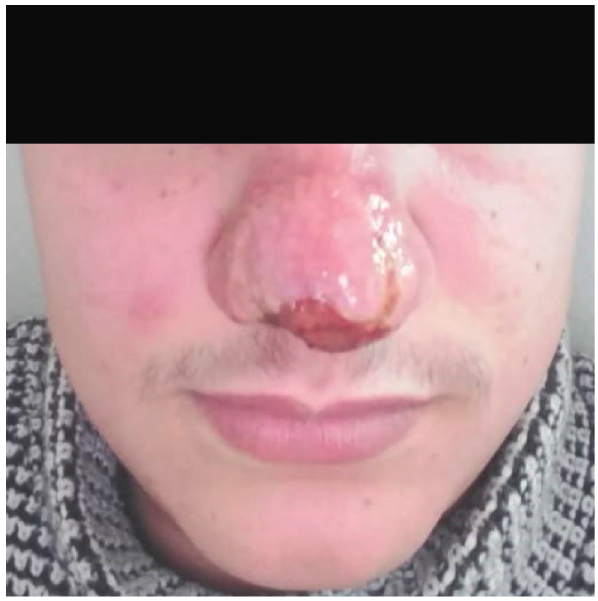
Figure 7: Response of the lesion to meglumine antimoniate treatment: 2 weeks after beginning of